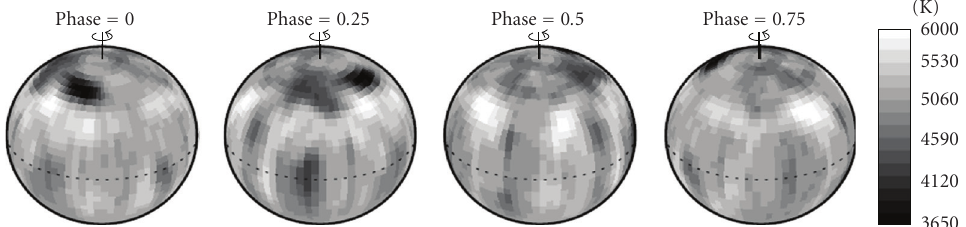
Figure 13: Doppler image of the rapidly rotating G giant FK Comae based on STELLA-I SES data. The map plots surface temperature according to the scale. It was taken from [16].